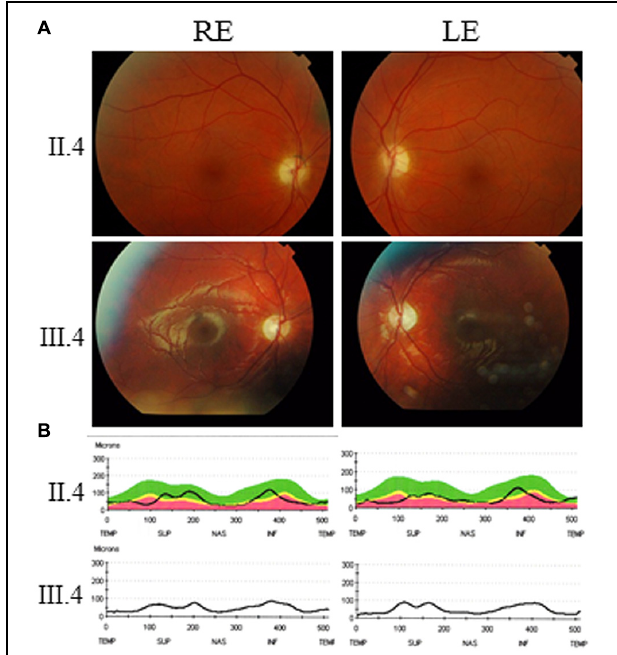
FIGURE 2 | Ophthalmological exploration of AFG3L2 patients. (A) Eye fundus (RE: right eye; LE: left eye) from patient II.4 (top) and patient III.4 (bottom) disclose temporal pallor of the optic disks. (B) Optical Coherence Tomography scanning and measurement of the retinal nerve fiber layers of the optic disks evidenced a drastic thickness reduction in the temporal and nasal quadrants of patient II.4 (top) and III.4